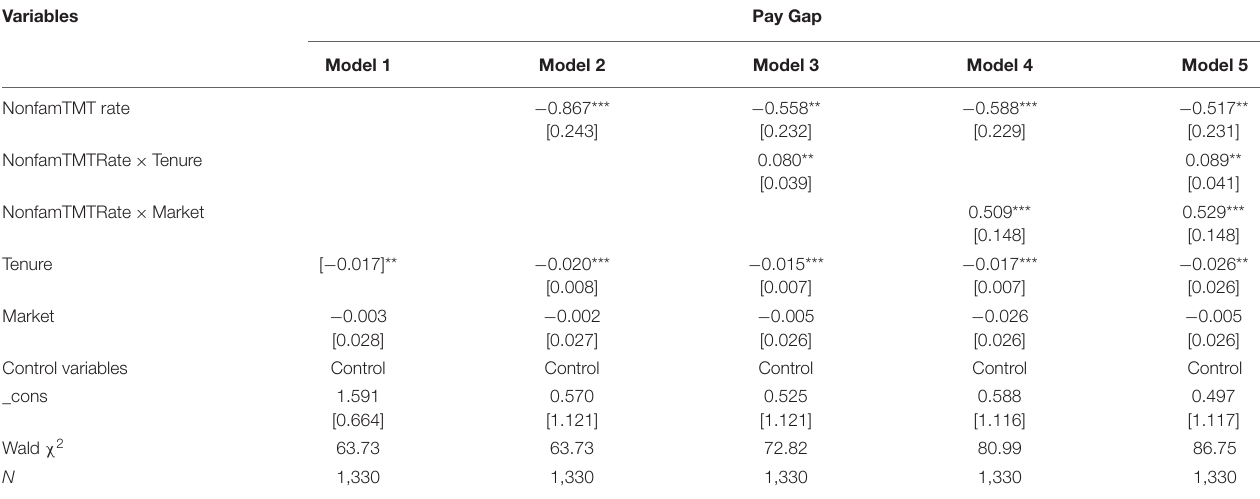
TABLE 5 | Robustness test: Substitute independent variable.